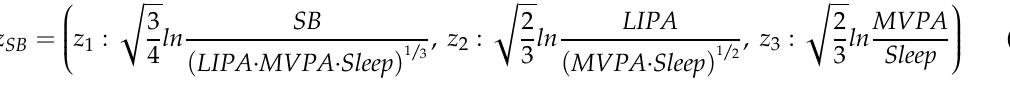
Table S1: Bivariate correlations between PA and SED variables, Table S2: Bivariate correlations between PA, SED, and GMV in the left and right hippocampi for the whole sample and stratified by weight